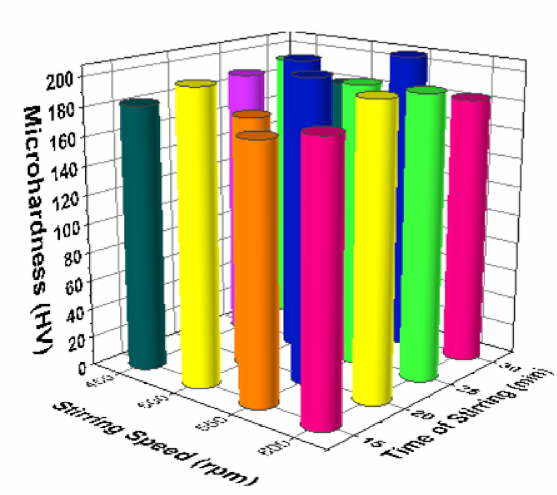
Figure 18. 3D bar plot: stirring speed vs. time of stirring.